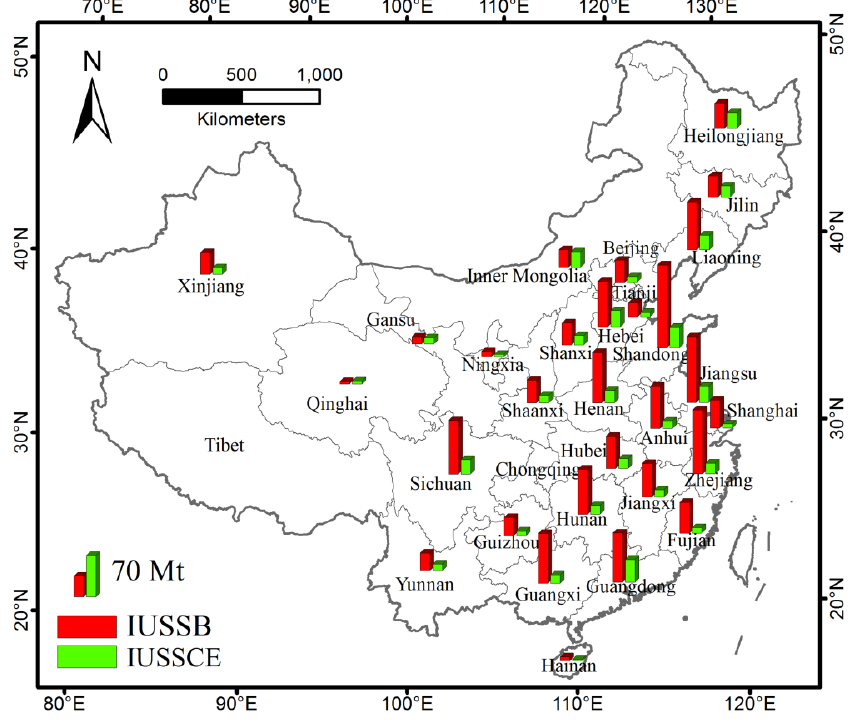
Figure 2. Distribution of provincial IUSSB and IUSSCE for mainland China in